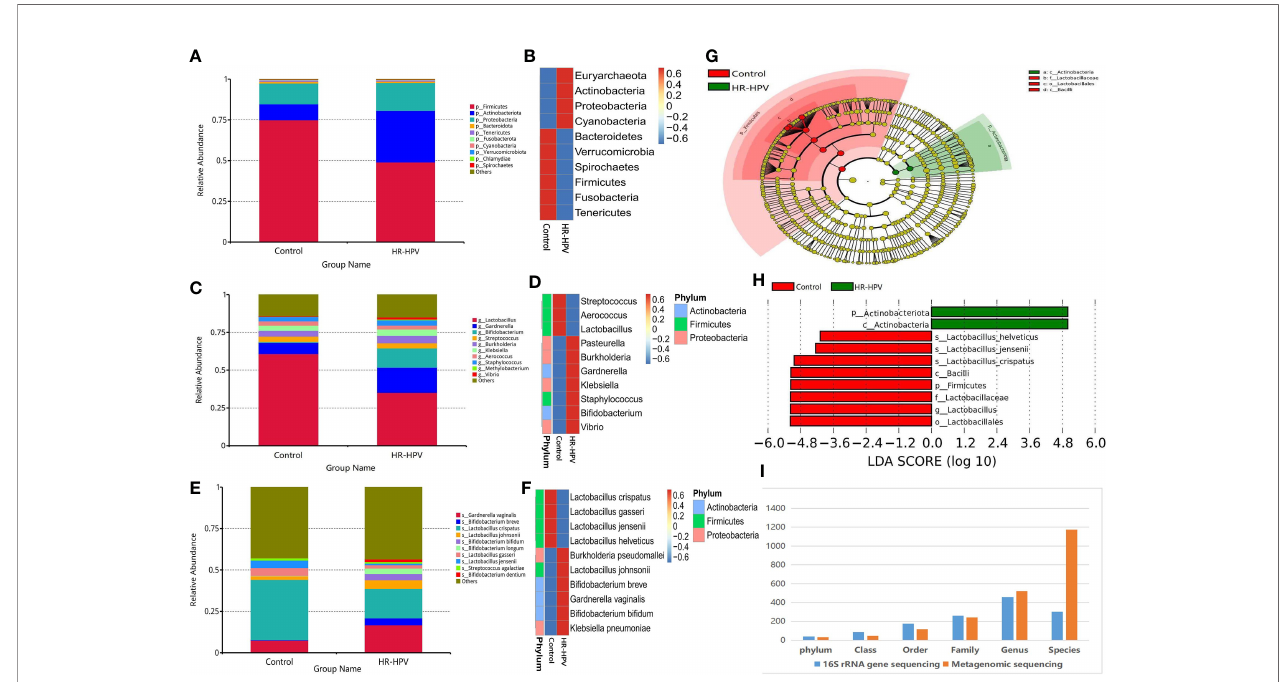
FIGURE 3 | Microbial composition based on metagenomic sequencing. (A) Relative abundance of the cervical microbiota at the phylum level. (B) Cluster heatmap of relative abundance at the phylum level. (C) Relative abundance of the cervical microbiota at the genus level. (D) Cluster heatmap of relative abundance at the genus level. (E) Relative abundance of the cervical microbiota at the species level. (F) Cluster heatmap of relative abundance at the species level. (G) LEfSe cladogram by metagenomic sequencing of the cervical microbiota in the two groups. Microbial compositions were compared at different species levels, from phylum in the outermost ring to family in the innermost ring. (H) Distribution histogram of LDA score assessed for species with biomarker signi fi cance between the HR-HPV infection and uninfected women ( P <0.05; LDA score >4). (I) Comparison of the accuracy of identifying bacteria between the 16S rRNA gene and metagenomic sequencing.